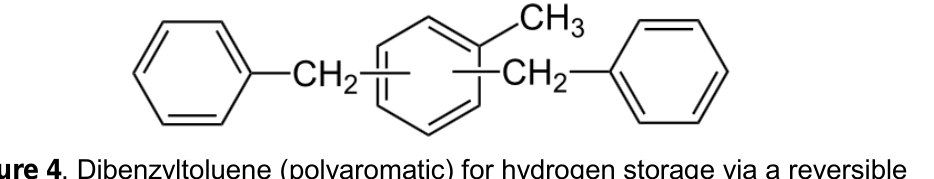
Figure 4 . Dibenzyltoluene (polyaromatic) for hydrogen storage via a reversible hydrogenation reaction